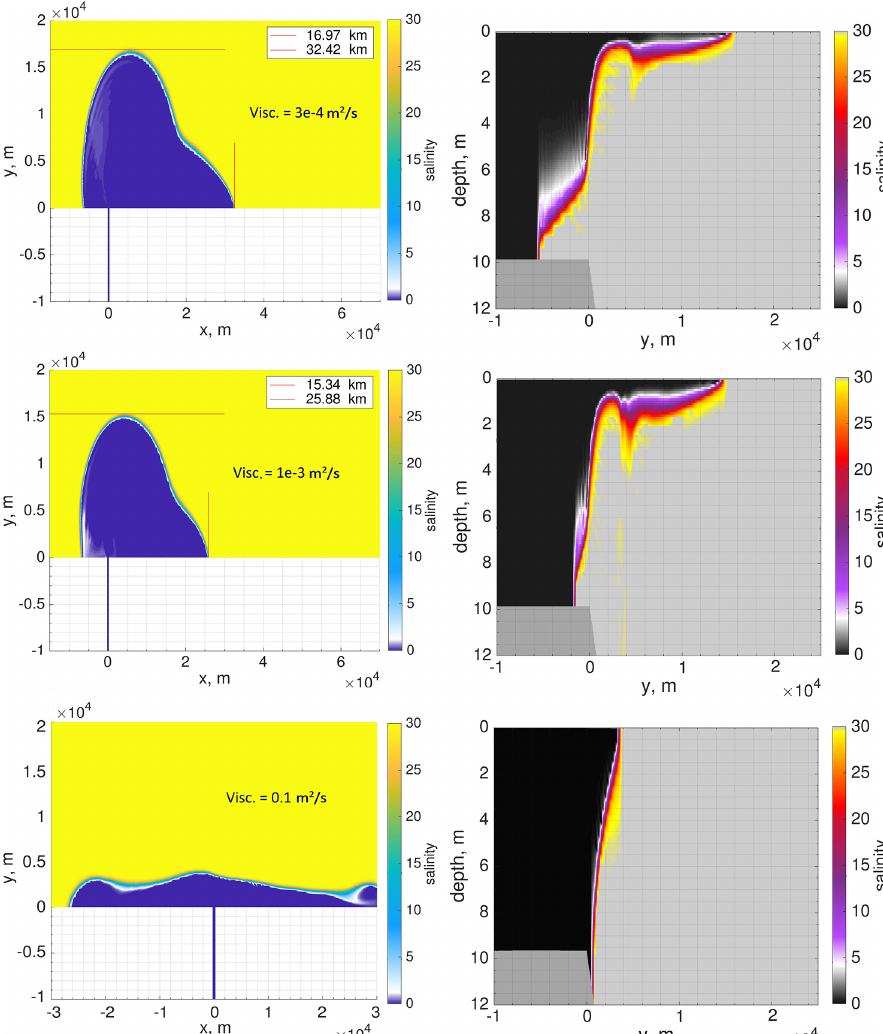
Figure 13. The surface salinity and salinity at the mouth transect at 35h with different background viscosity levels (runs 8a, b, and c from top to bottom).